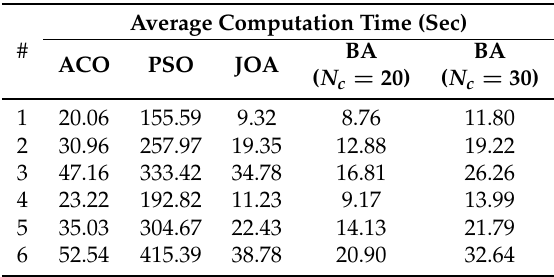
Table 4. Average computation time in the first